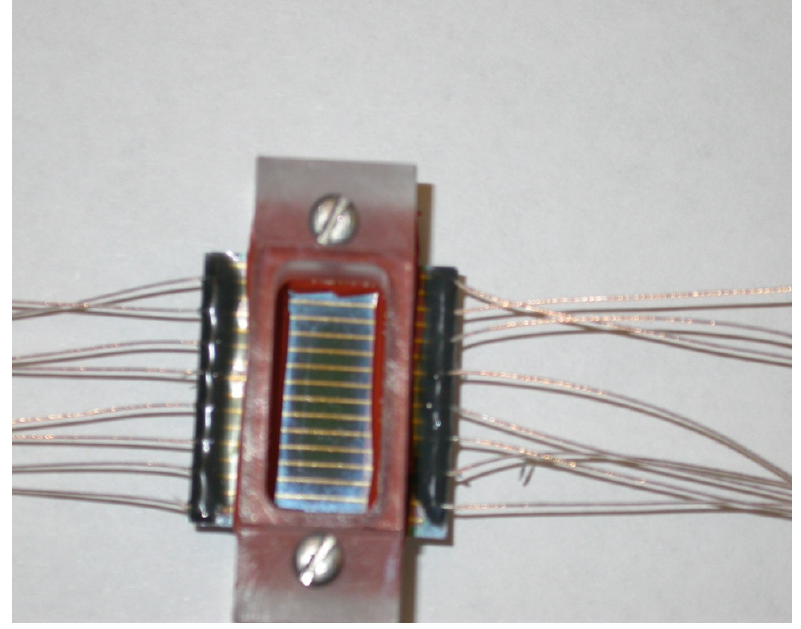
Figure 3. Conductivity sensor and testing cell assembled, one working electrode and a total of 12 counter